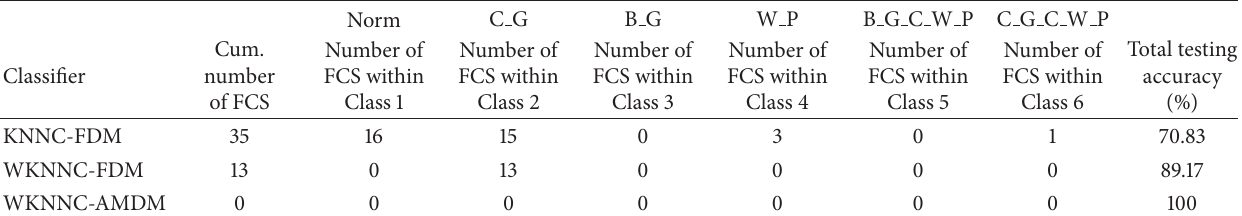
Table 4: Fault diagnosis results of three different classifiers with the reduced low-dimensional tensor formed multisensor fused samples.